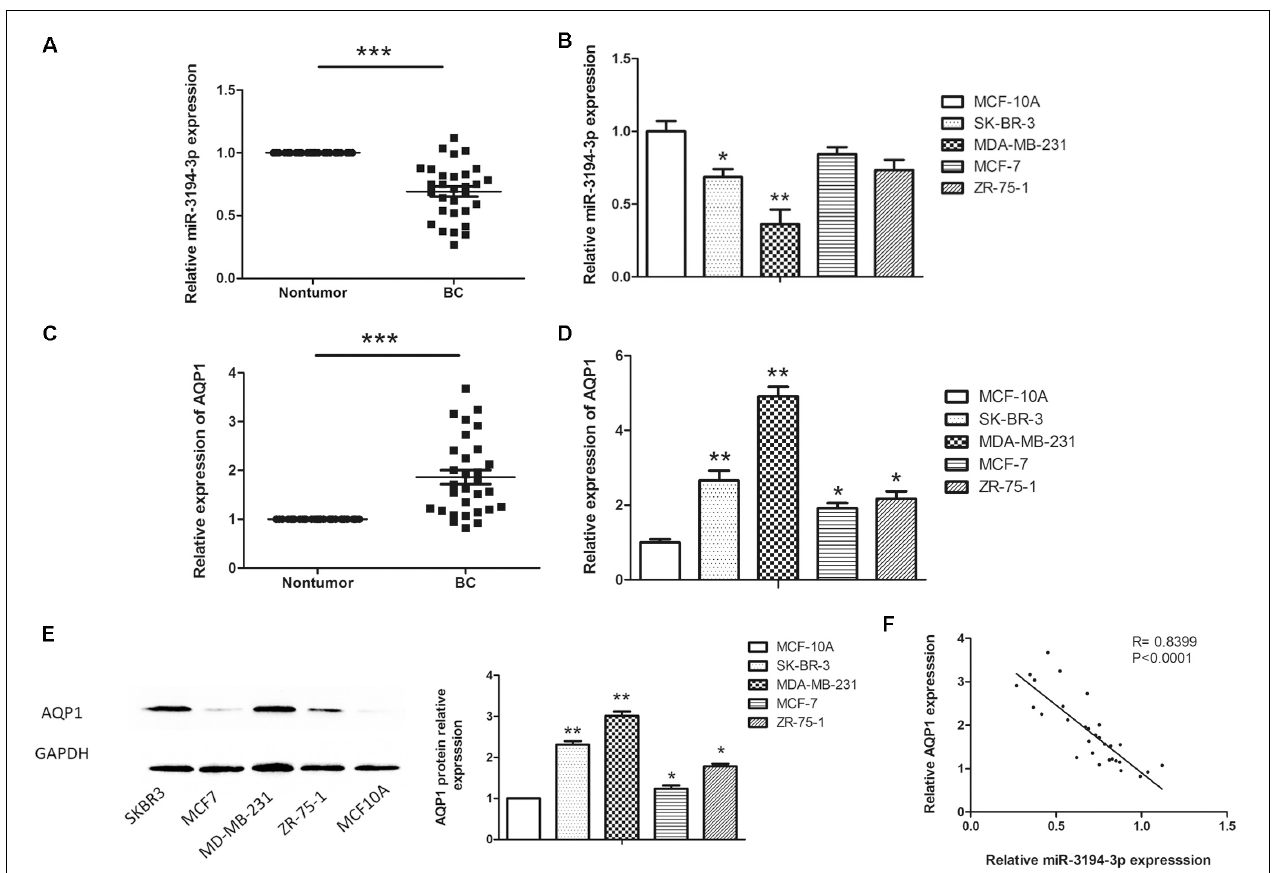
FIGURE 1 | The miR-3194-3p and AQP1 expression levels in BC tissues and cell lines. Comparing differences in the expression levels of miR-3194-3p between (A) BC and adjacent non-tumor tissues ( n = 30); (B) BC cell lines and the control breast epithelial cells (MCF-10A); differences in AQP1 mRNA level between (C) BC and adjacent non-tumor tissue; (D) BC cell lines and MCF-10A; differences in AQP1 protein level between (E) BC cell lines and MCF-10A. (F) A significant inverse correlation between miR-3194-3p and AQP1 expression was observed in BC tissues. All PCR reactions were performed independently in triplicate (* P < 0.05, ** P < 0.01, and *** P <